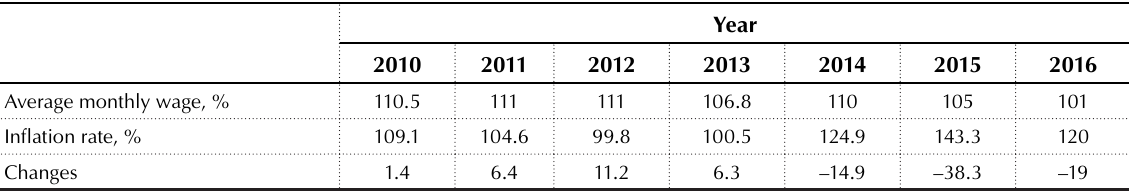
Source: Internet site of the National Bank of Ukraine (2016).